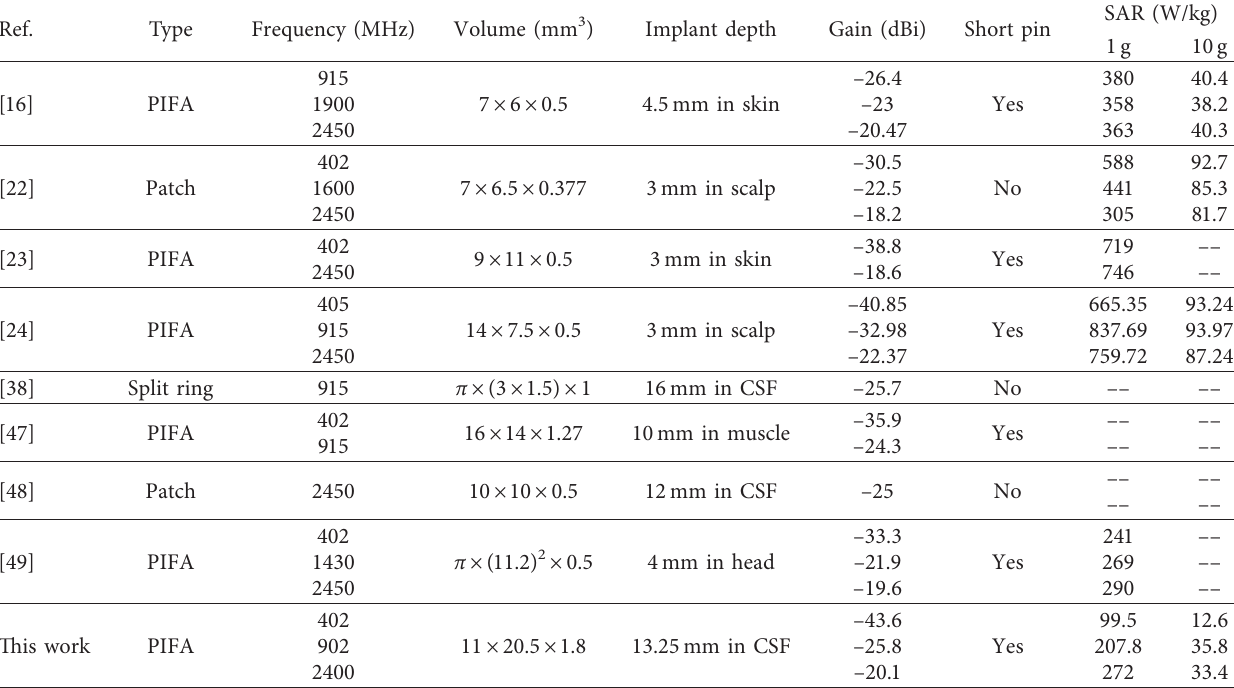
Figure 15: Comparison of implantable antennas’ gain versus electrical size ( ka ). The red, blue, green, and purple markers, respectively, are used for the implant depth < 3mm, 3 mm < implant depth ≤ 9 mm, 9mm < implant depth ≤ 15mm, and implant depth > 15mm. Circle, square, and triangle markers indicate single-, dual-, and multiband implantable antennas, respectively. The numbers in the figure refer to the list of references. Table 4: Comparison of implantable